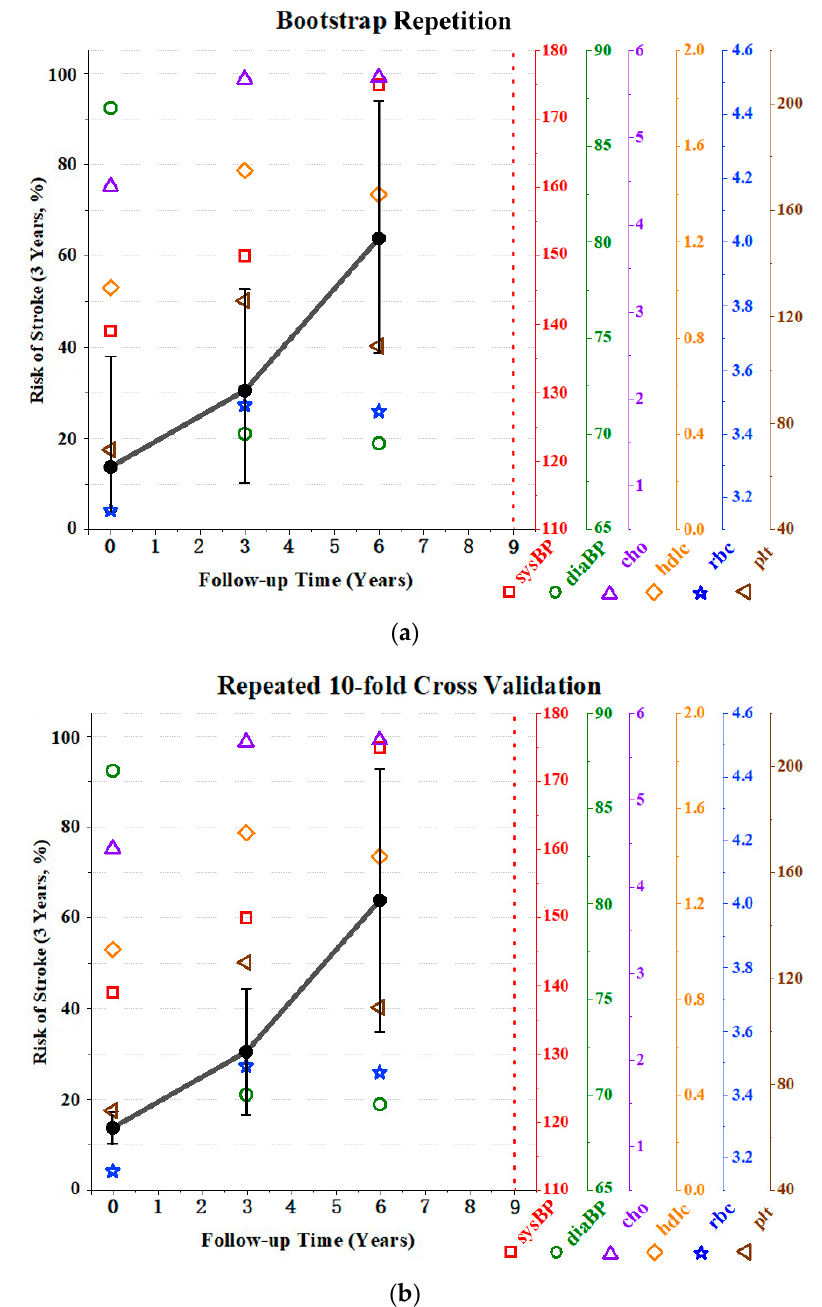
Figure 5. Comparison of the confidence interval using ( a ) bootstrap repetition and ( b ) repeated 10-fold cross-validation on Subject 1. Follow-up years of 0, 3, 6, and 9 equate to 2008, 2011, 2014, and 2017, respectively. The left y -axis is the three-year risk of stroke. The right y-axes are values of longitudinal risk factors: sysBP—systolic blood pressure (mmHg); diaBP—diastolic blood pressure (mmHg); cho—total cholesterol (mmol/L); hdlc—high-density lipoprotein cholesterol (mmol/L); rbc—red blood cell count (10 12 /L); and plt—platelet count (10 9 /L). Black dots indicate the three-year risk of stroke at each measurement. Connected plain black lines represent the risk change trend. The vertical interval of each point is the confidence interval calculated by repeated 10-fold cross-validation. The vertical red dotted line is the time point of being identified as having had a stroke.